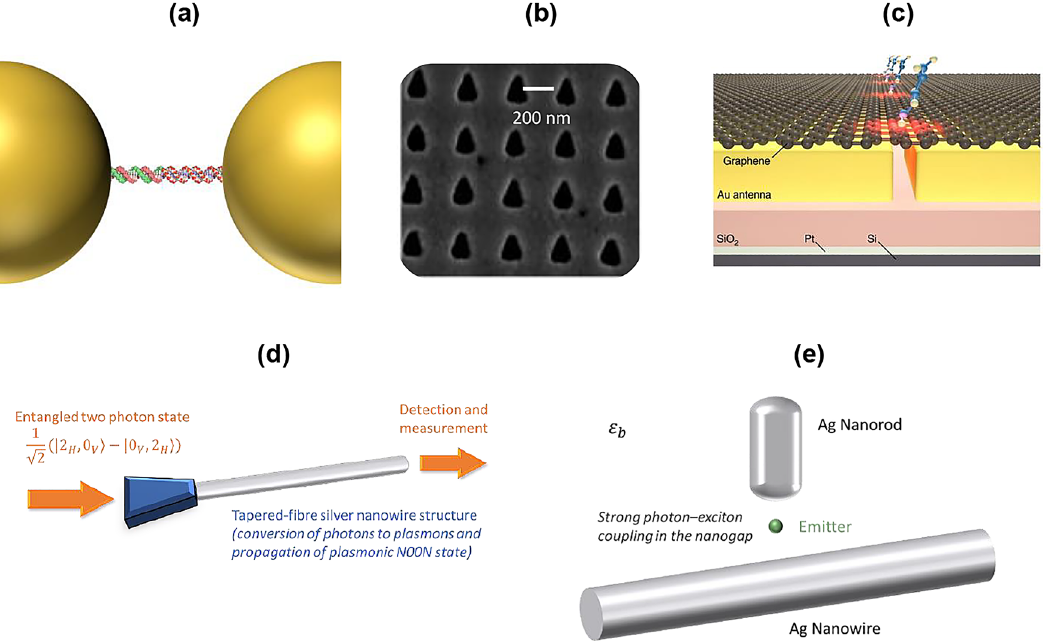
Figure 14: (a) DNA linker in a plasmonic nanoparticle dimer increases the range of coherent charge transfer. Adapted from the study by Lerch and Reinhard [305] with DNA linker illustration by David S. Goodsell and the RCSB PDB under CC-BY-4.0 license. (b) Plasmonic